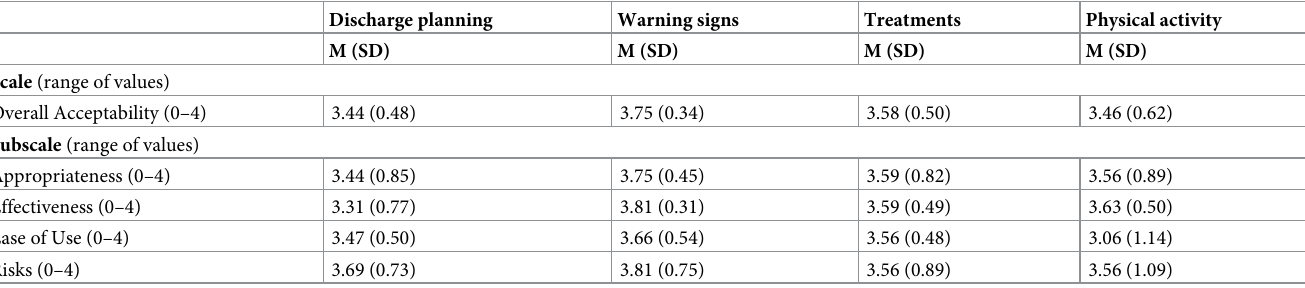
Table 1. Descriptive results of participants’ acceptability ratings of the